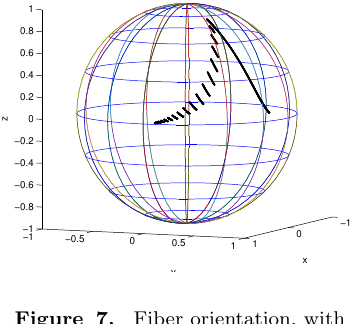
Figure 7. Fiber orientation, with recoiling model R2.